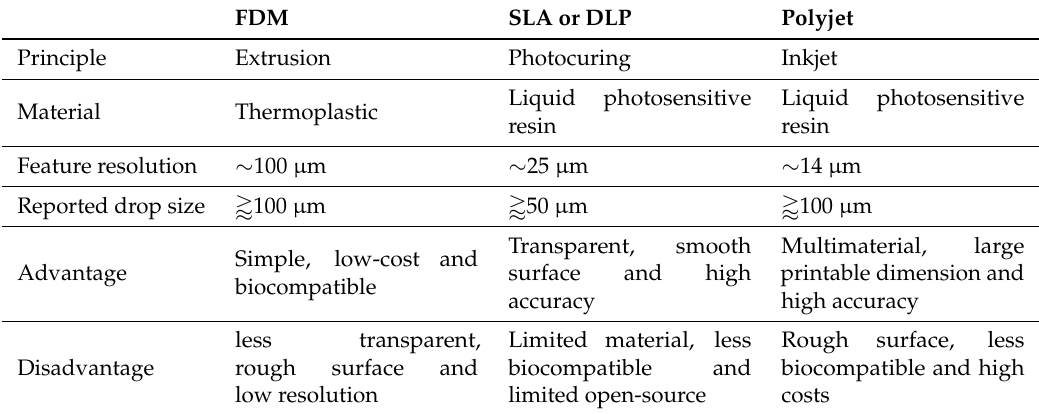
Table 2. Summary of current 3DP techniques suitable for droplet